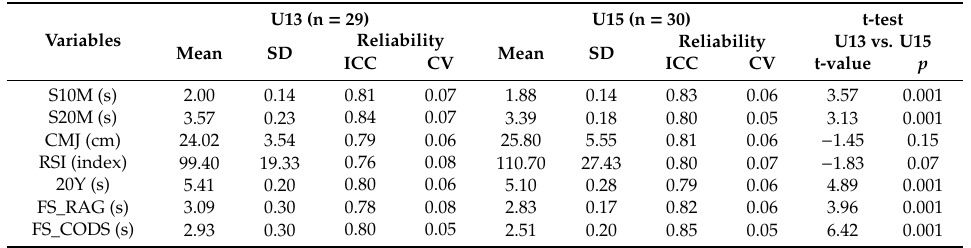
Table 2. Intra-testing reliability of the applied tests of fitness capacities in each age category with di ff erences between age categories derived by independent samples